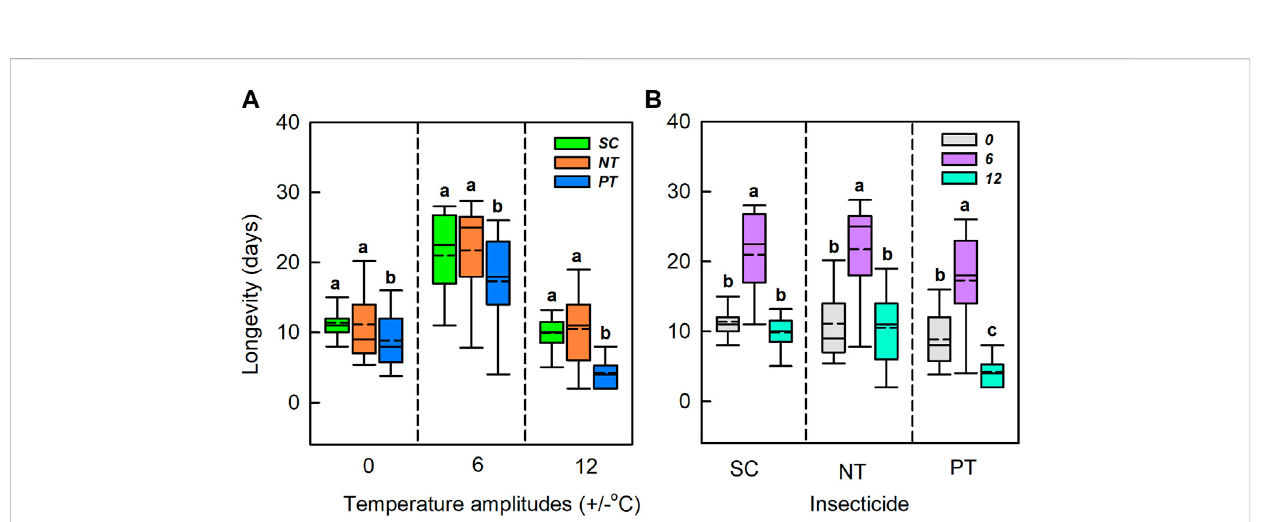
FIGURE 3 Boxplotofthelongevityundervarioustemperatureamplitudes (A) andinsecticides (B) .Theupperandlowerboundariesoftheboxindicatethe75th percentile and 25th percentile of the dataset. The black horizontal line and short dash line within the box represent the median and mean values, respectively. Error bars above and below the box indicate the minimum and maximum values, respectively. Different letters above each box indicate signi fi cant differences ( p < 0.05) among the